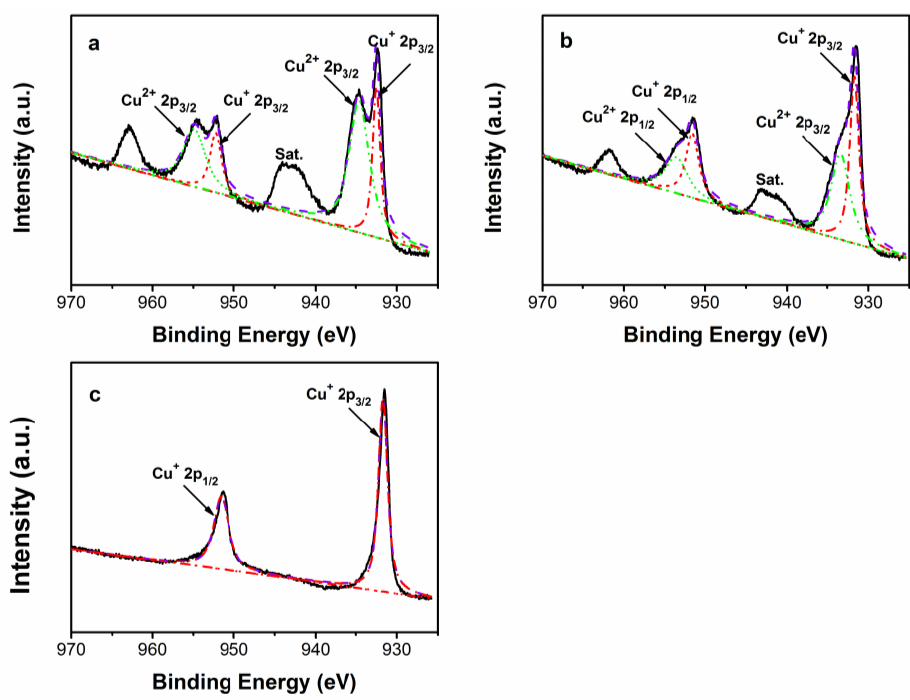
Figure 6. High-resolution X-ray photoelectron spectroscopy (XPS) scan of Cu 2p ( a ) Cu 3 Se 2 ; ( b ) Cu 1.8 Se/Cu 3 Se 2 composite; ( c ) Cu 1.8